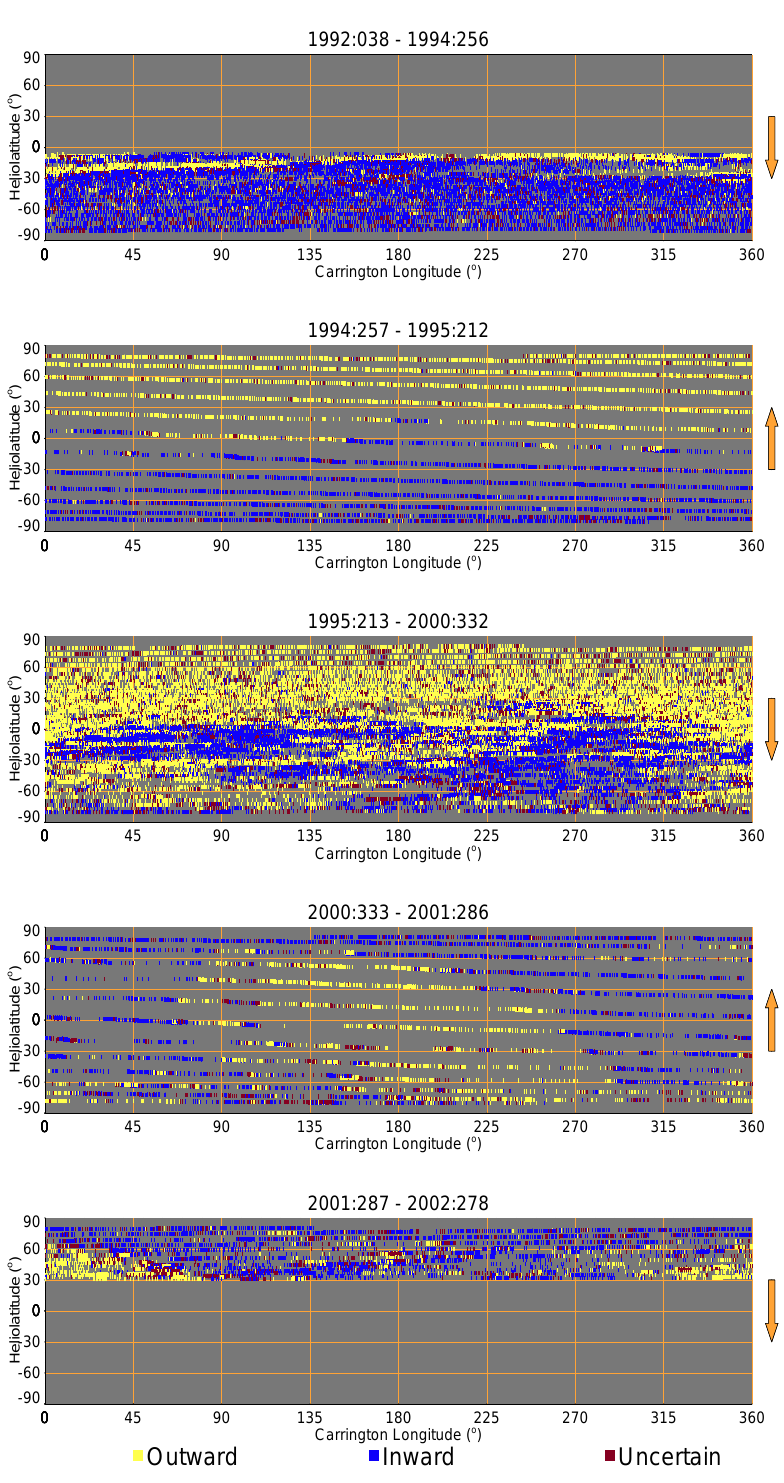
Fig. 2. The polarity distribution at the solar wind source surface plotted in a Mercator projection in the Carrington frame of reference. Each plot displays a distinct mission phase. The arrows to the right of the plot denote the direction in which Ulysses was moving in heliolatitude. The colours employed are defined in the